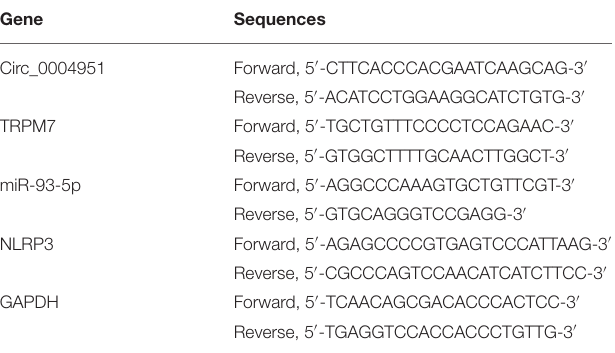
TABLE 1 | The sequences of the PCR primer pairs used in this